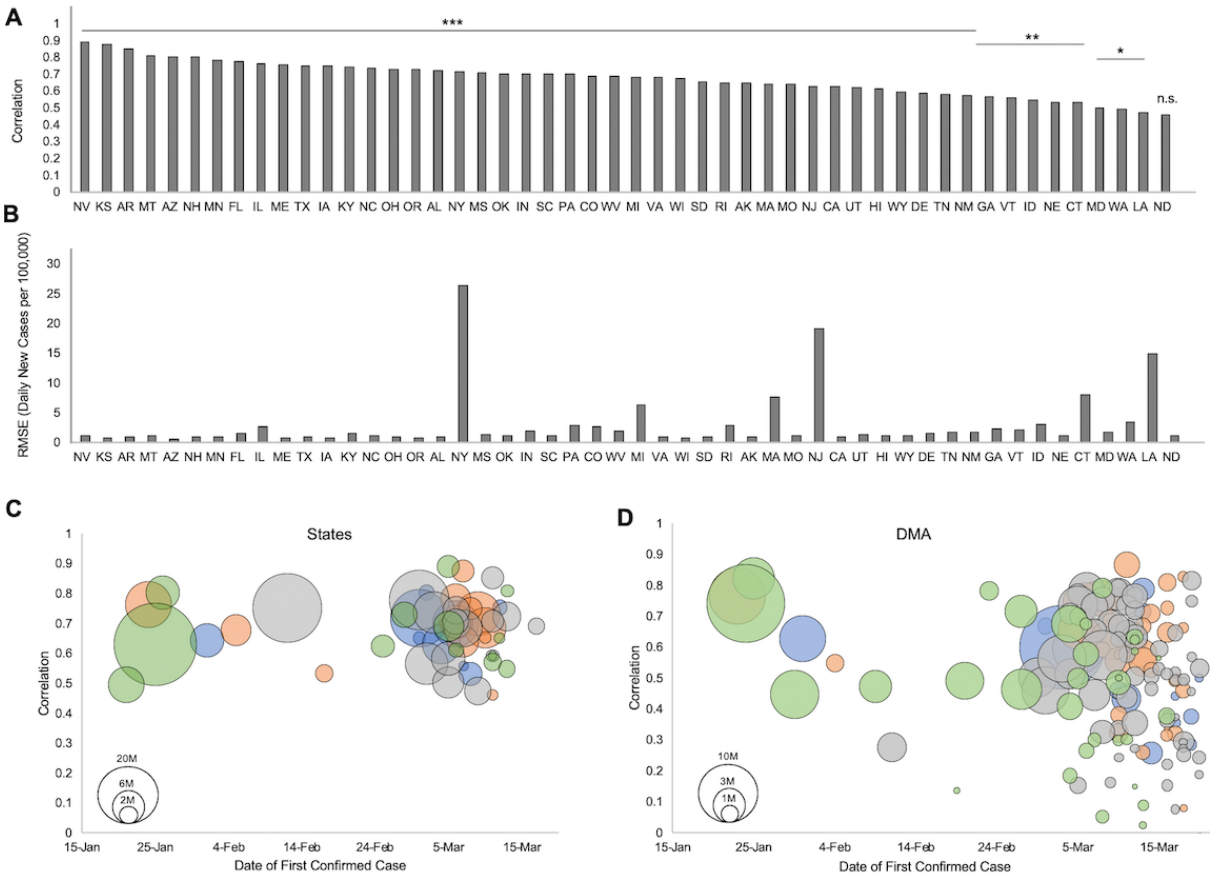
Figure 1. Correlation of query predictions with regional coronavirus disease (COVID-19) confirmed case rates. (A) Correlation of predicted case rates with actual case rates for the 50 states. Values are Pearson correlation coefficients. * indicates significance at α =.05; ** at α =.01; *** at α =.005. (B) Root-mean-square error (RMSE) between predicted case rates and actual case rates for the 50 states, in units of daily new cases per 100,000 population. (C) Prediction correlations at the state level do not depend on outbreak timing, as measured by the date of the first confirmed case. Circle size indicates the relative population of the state. Color indicates US census-designated region (blue: Northeast; orange: Midwest; gray: South; green: West). (D) Prediction correlations at the designated market area (DMA) level do not depend on outbreak timing, as measured by the date of the first confirmed case. Circle size indicates the relative population of DMA. Color indicates the US census-designated region, as described. n.s.: not